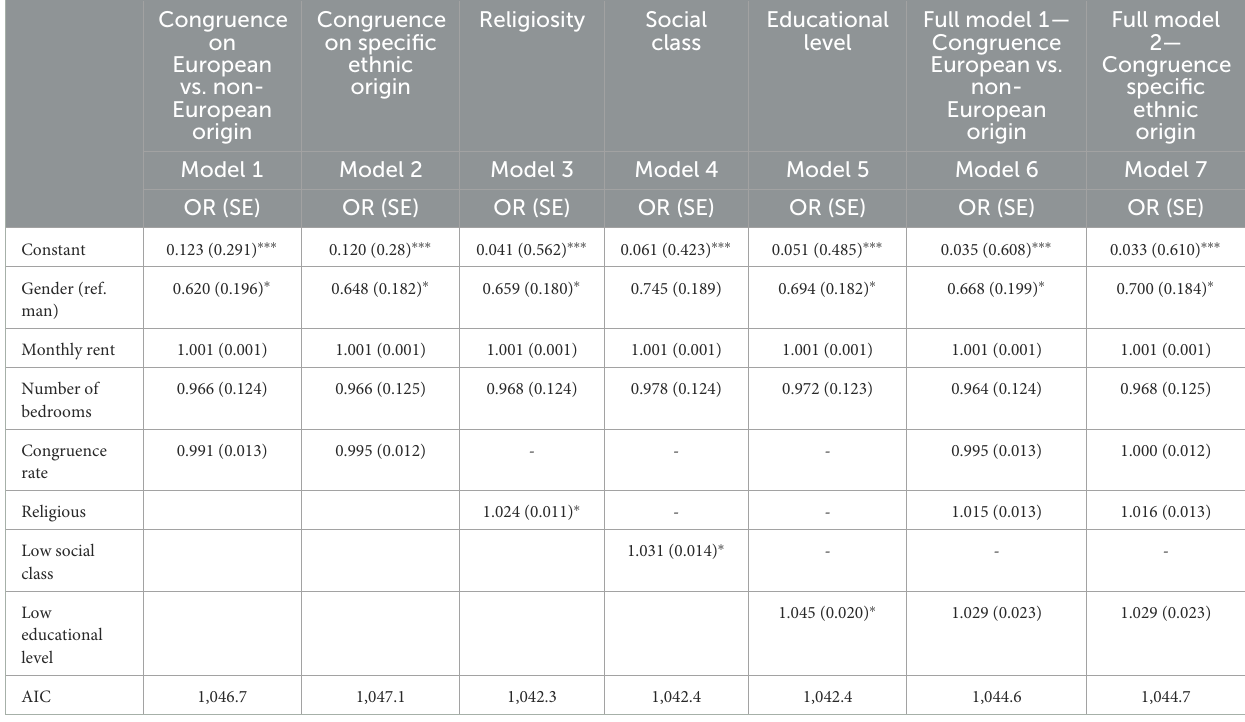
TABLE 5 Binary logistic regression on negative discrimination by real estate agents ( n =